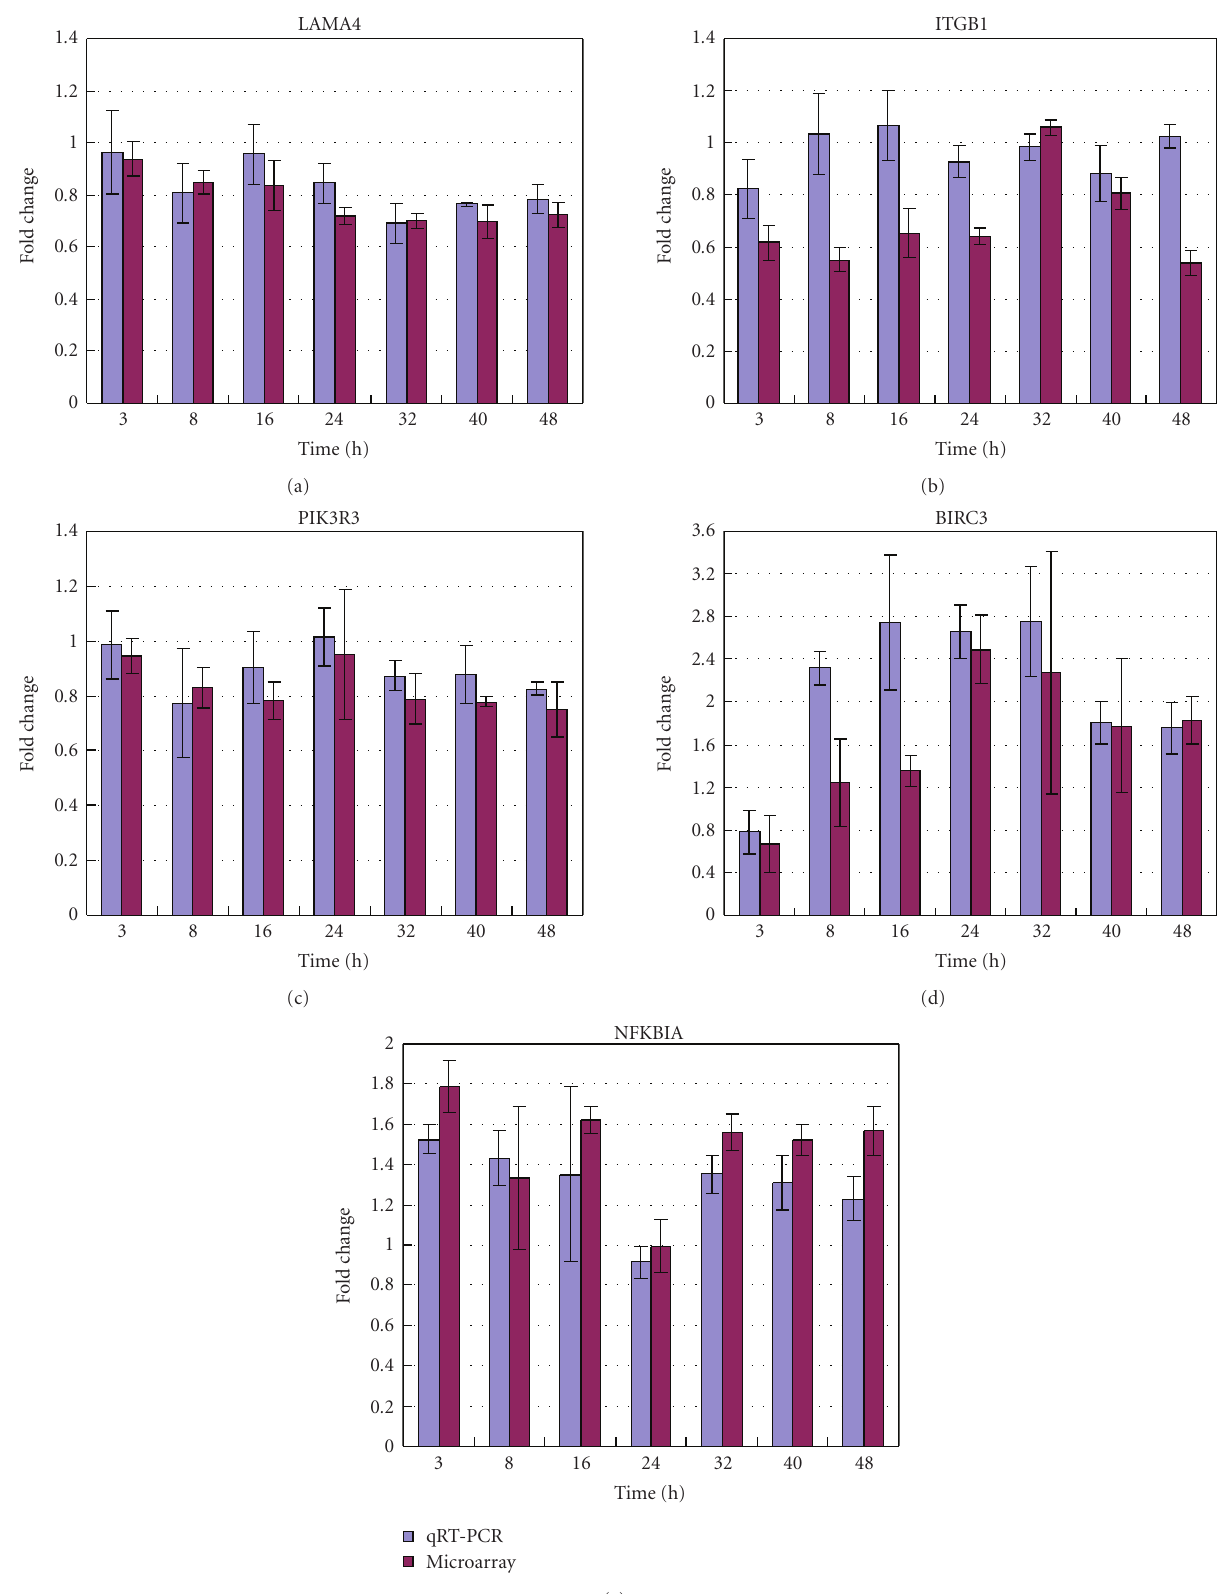
Figure 4: Validation of microarray data by qRT-PCR analysis for 5 genes: (a) LAMA4, (b) ITGB1, (c) PIK3R3, (d) BIRC3, and (e) NFKBIA. The data are expressed as mean values ( ± standard deviation) of three